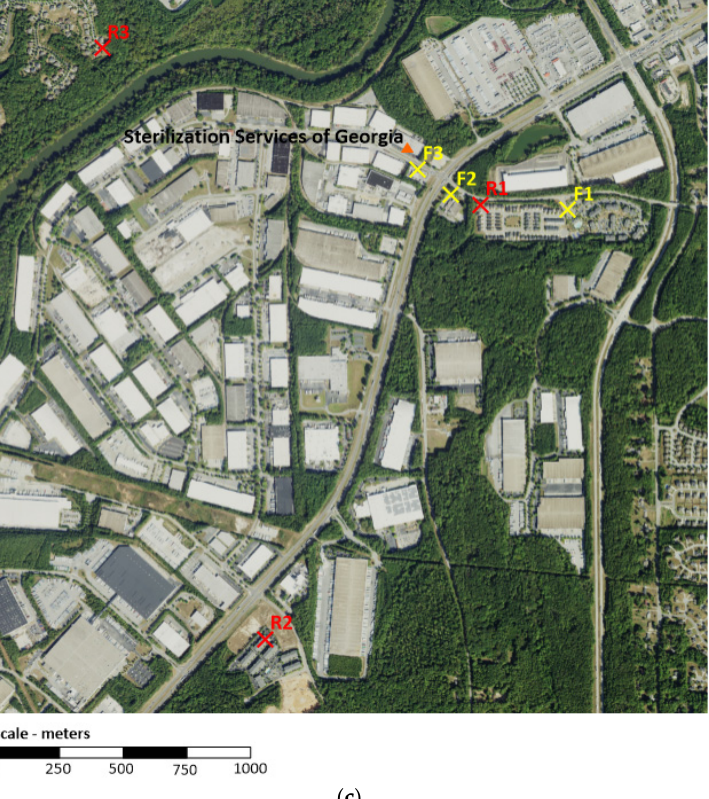
Figure 1. ( a ). Modeled (red) and monitored (yellow) sites around Becton Dickinson (Covington, Georgia). ( b ). Modeled (red) and monitored (yellow) sites around Sterigenics (Smyrna, Georgia). ( c ). Modeled (red) and monitored (yellow) sites around Sterilization Services (Atlanta, Georgia); sample site F4, which is not shown, is located more than ~5000 m northwest of Sterilization Services.